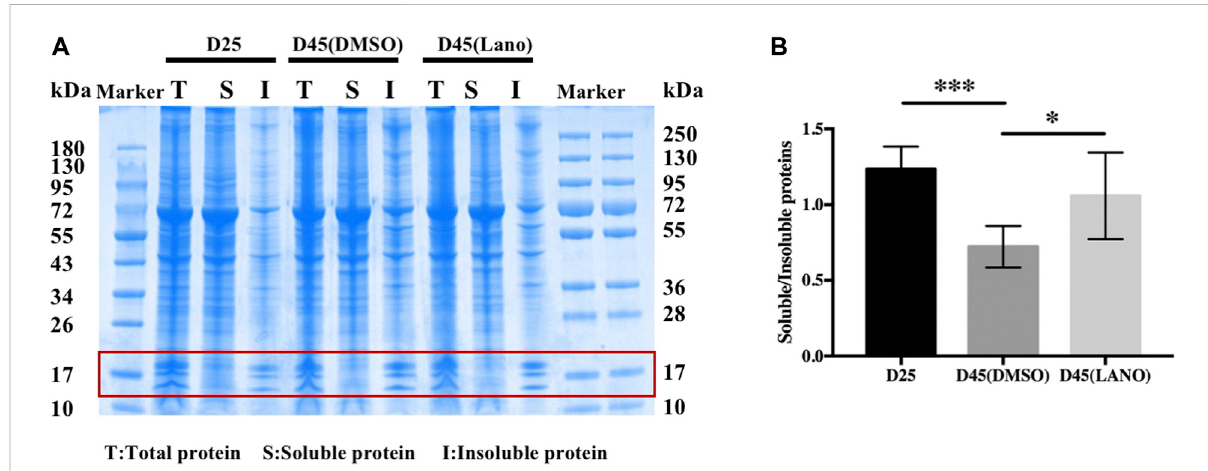
FIGURE 3 Soluble and insoluble protein concentration determination of control and lanosterol treated LBs. (A) Concentration of soluble and insoluble proteinswasdeteminedbySDS-PAGEgelelectrophoresiscombinationwithcoomassiebluestaining. (B) Quantitativeanalysisofbandsaround20kd region (red box) showed that the increase of insoluble protein was less in the lanosterol treated LBs than the control LBs. Bars represent mean ± SD ( n = 4). * p < .05, *** p < .001. T, total protein; S, soluble protein; I, insoluble protein. DMSO, dimethyl sulfoxide. Lano,